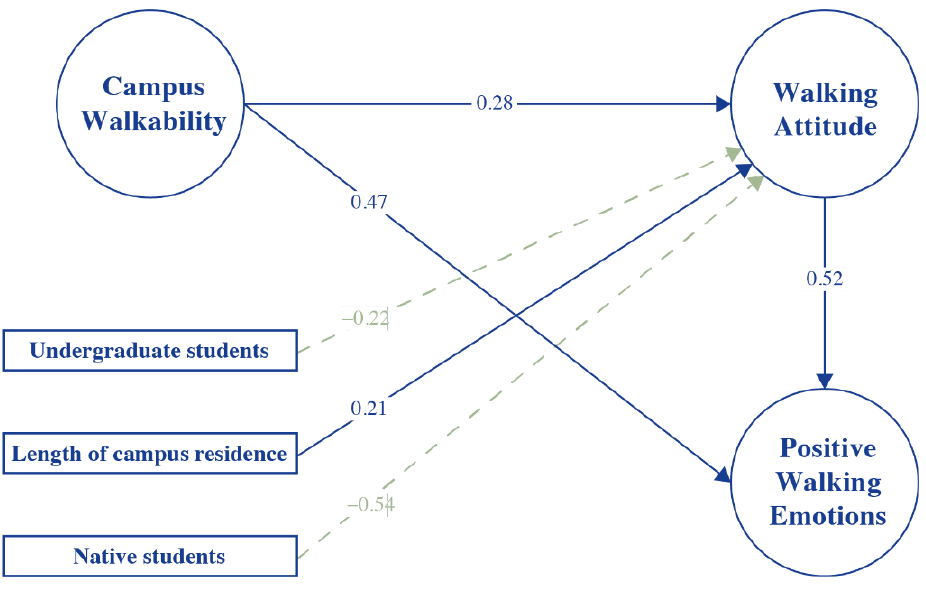
Figure 3. Standardized direct path coefficients SEM.